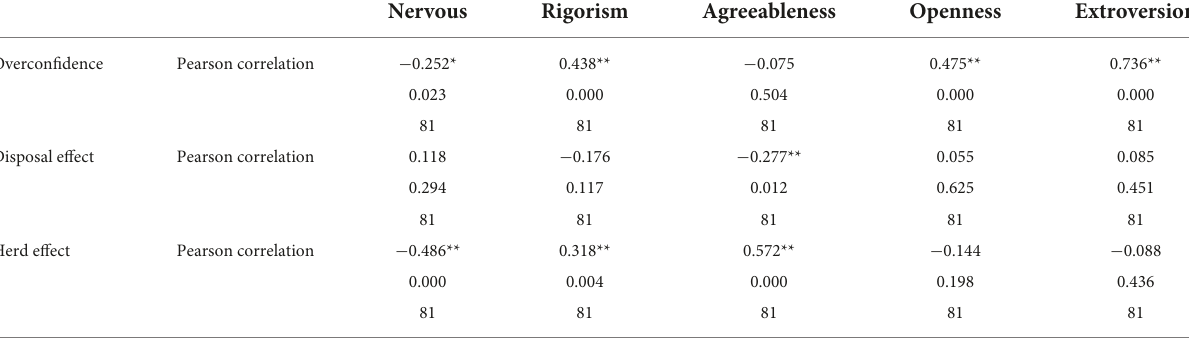
TABLE 1 Personality trait dimension-irrational behavior correlation analysis results.